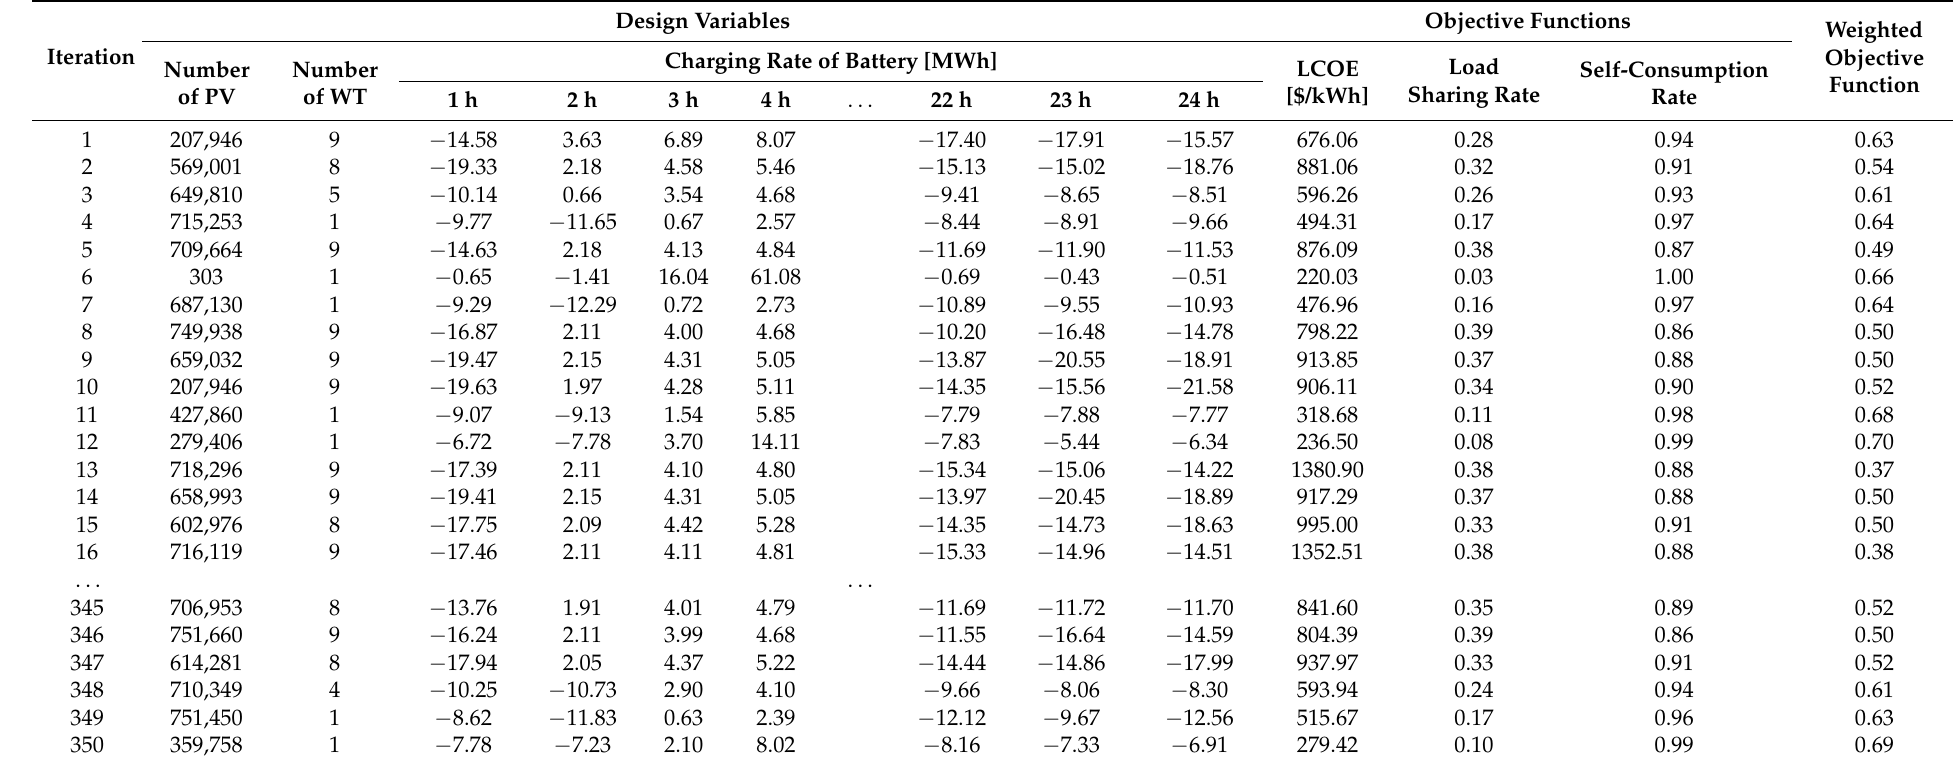
Table A1. Variations in design variables and objective functions according to the number of calculations for case